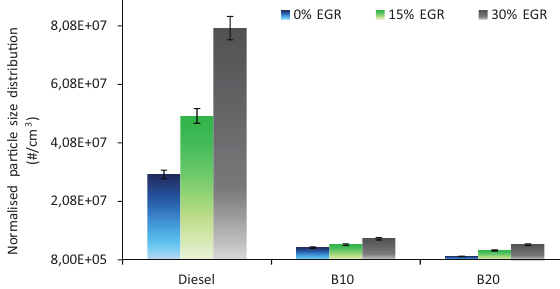
Figure 10. Effect of alcohol blends and different EGR rates on particle size distribution under 1800